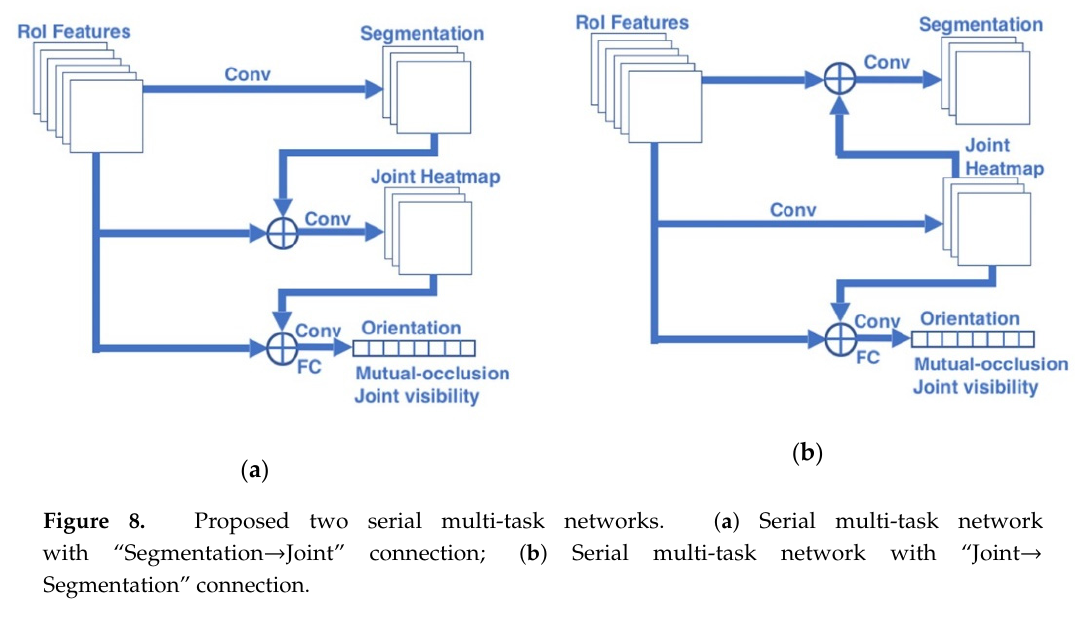
Figure 8. Proposed two serial multi-task networks. ( a ) Serial multi-task network with “Segmentation → Joint” connection; ( b ) Serial multi-task network with “Joint → Segmentation”